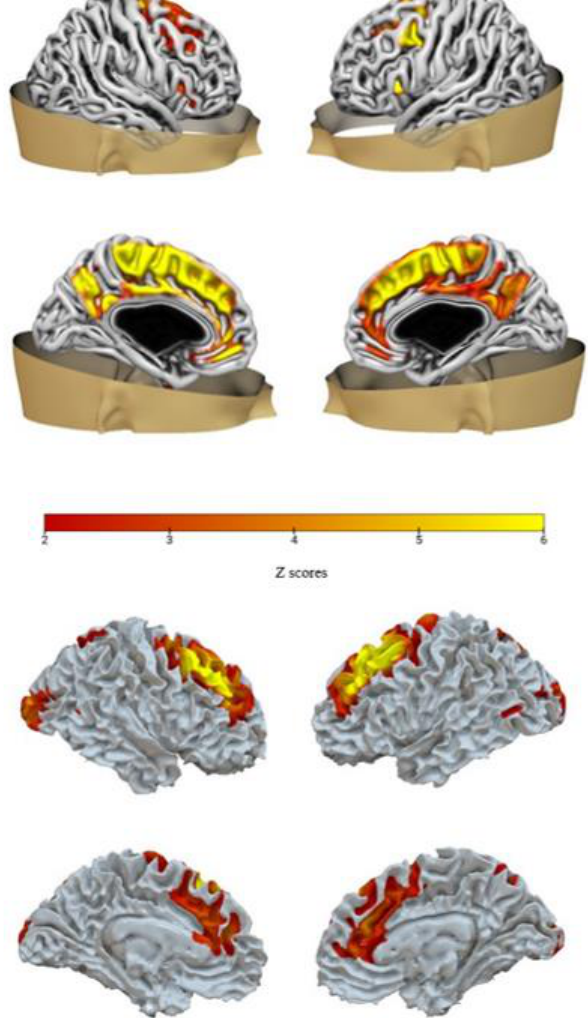
Figure 3. Network 2. Brain plot of IC-GM11 ( top ) and of IC-WM8 ( bottom ). Only positive values were found for both components.